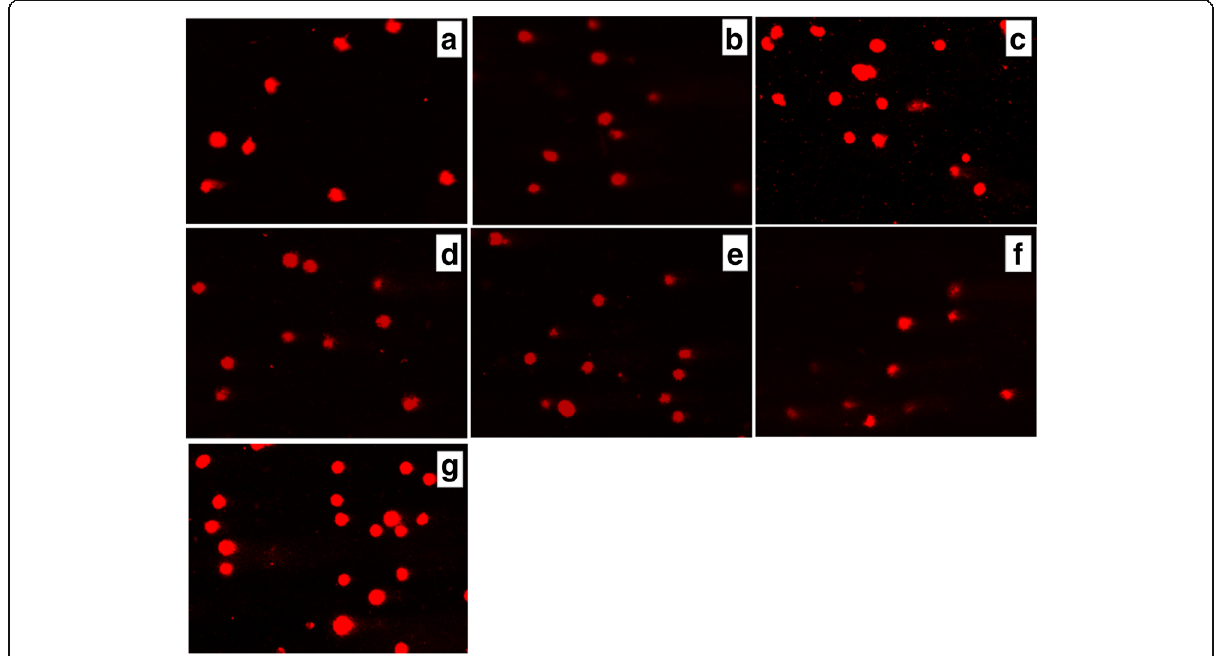
Fig. 10. Presence of DNA in comet tail of rat glioma С 6 cells after treatment for 3 h with ( a ) control (untreated cells), Les-3288 ( b ), Les-3288+PNC ( c ), Les-3833 ( d ) Les-3833 + PNC ( e ), PNC ( f ) and doxorubicin ( g ), used at a 0.5 μ g/mL concentration